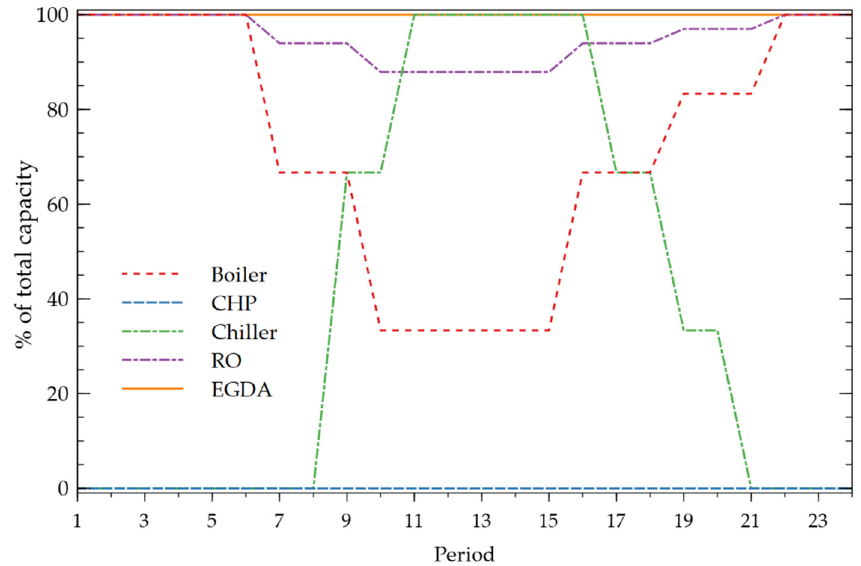
Figure 9. Operating state of the units for the different periods in alternative with no storage units and no CO 2 limitation.